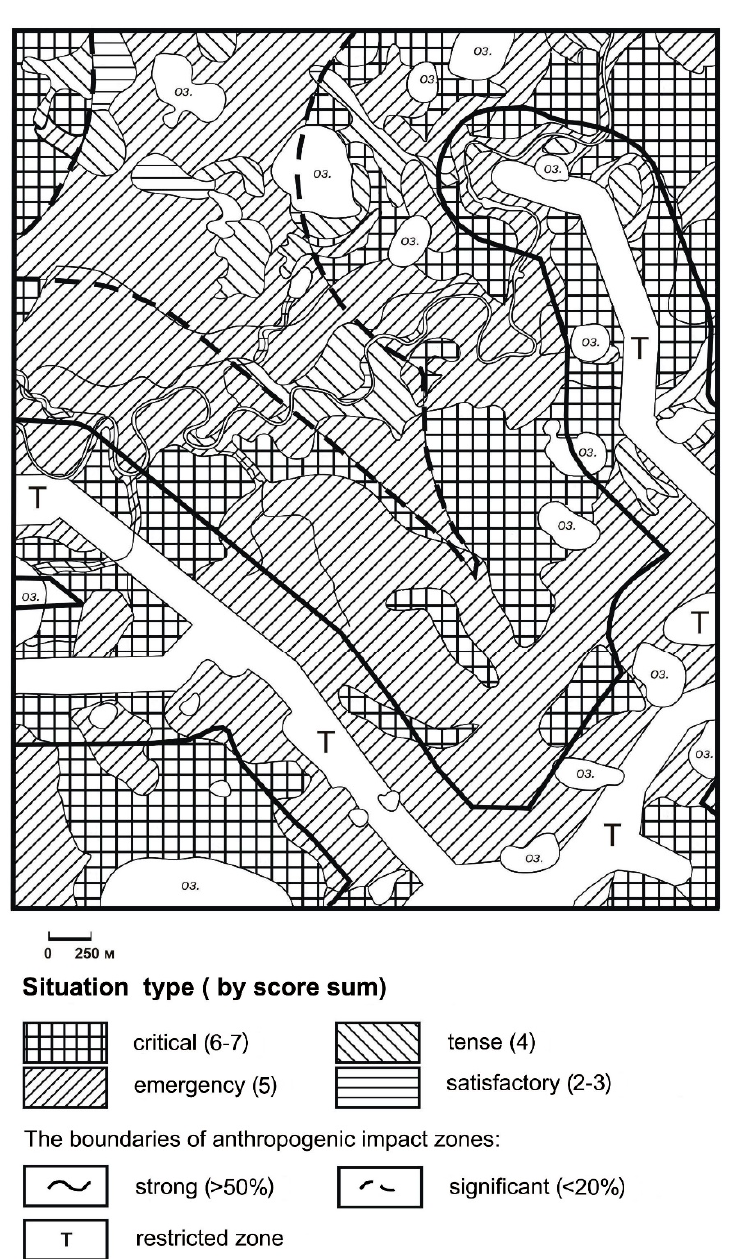
Figure 10. Fragment of the geoecological situations map for the Yamburg field.